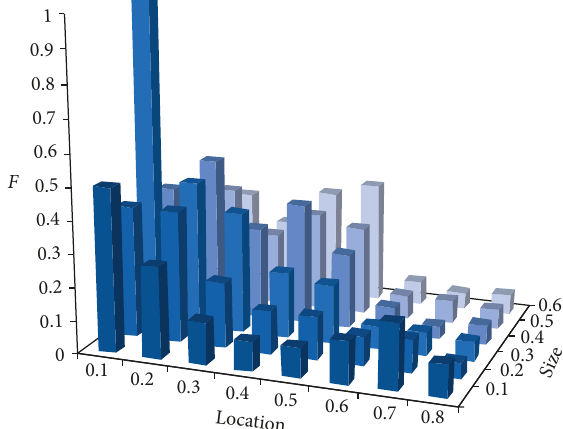
Figure 11: Damage index for the first crack of a multicracked [1386] composite beam using 5 modes with measured error ranging from 2 to 3%.